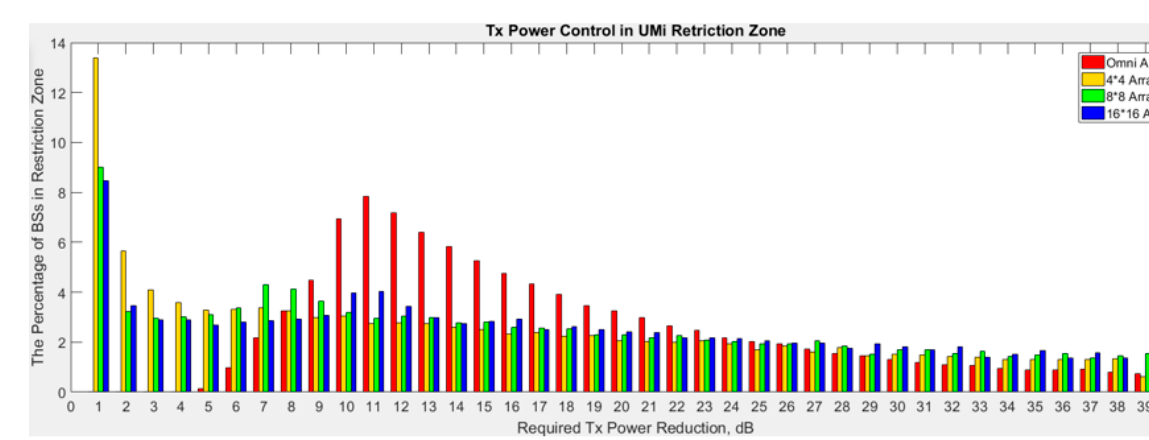
Figure 30. Sizes of the exclusion and restriction zones for UMi.